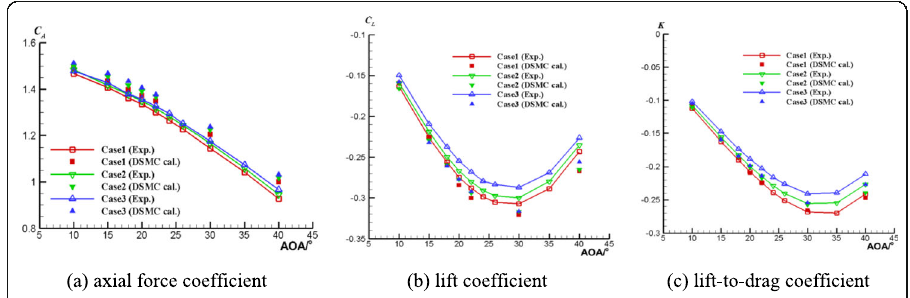
Fig. 4 Aerodynamic characteristics of the Shenzhou reentry capsule. a axial force coefficient. b